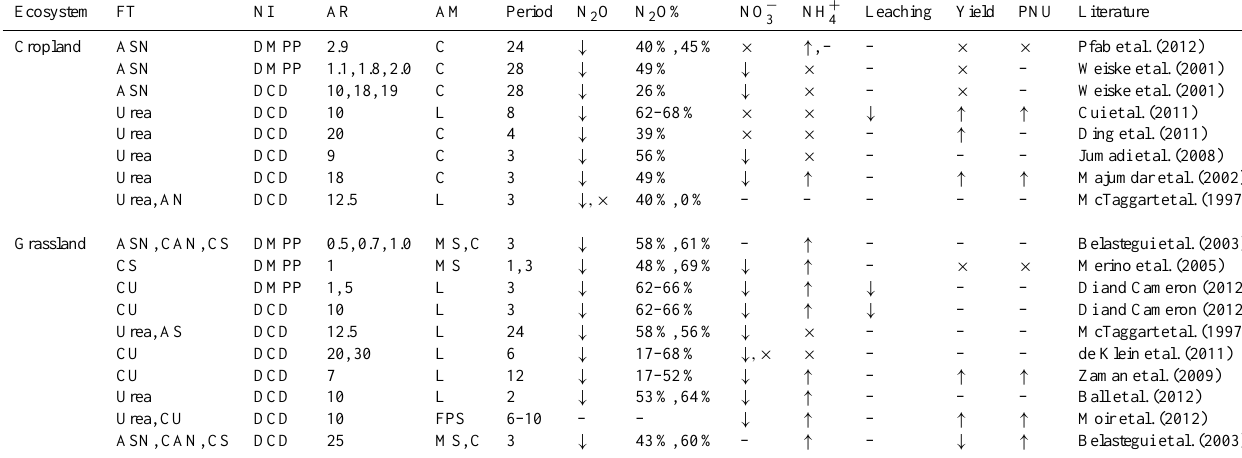
Table 4. The (inhibited: ↓ ; enhanced: ↑ ; no: × ; and not measured: –) effects of DCD and DMPP on N 2 O emission (N 2 O), soil nitrate (NO − and ammonium (NH + ) contents, NO − leaching, yield and plant nitrogen uptake (PNU). 4 3